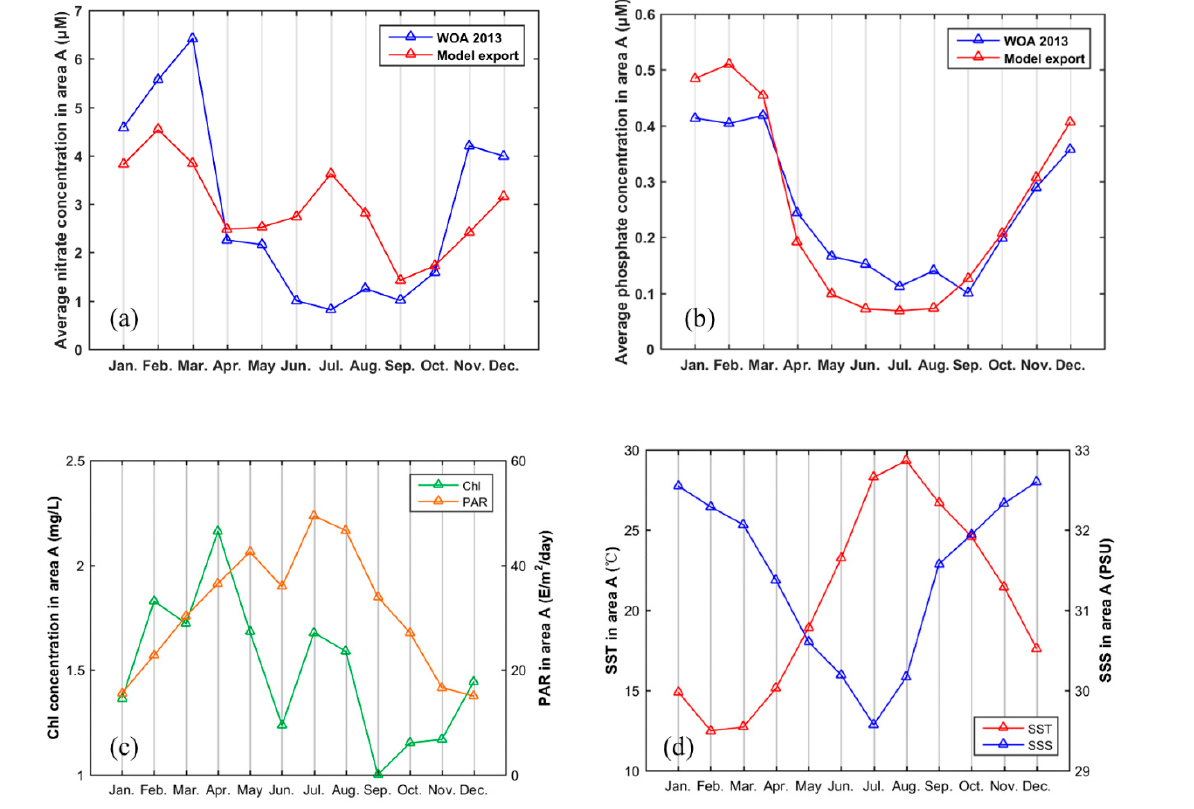
Figure 11. ( a , b ) Comparisons of monthly average nutrient concentration from model estimates and the World Ocean Atlas data (WOA13, V2) in Zone A (Figure 1). ( c , d ) Monthly average changes in chlorophyll concentration, photosynthetically active radiation (PAR), sea surface temperature (SST), and sea surface salinity (SSS) in Zone A. Table 4. Monthly average changes in nutrients and other related elements in Zone A. I (increase), D (decrease), and - (stable) describe the monthly changes. The interrelationships between changes in Winter Spring Summer Autumn Dec. Jan. Feb. Mar. Apr. May Jun. Aug. Sep.